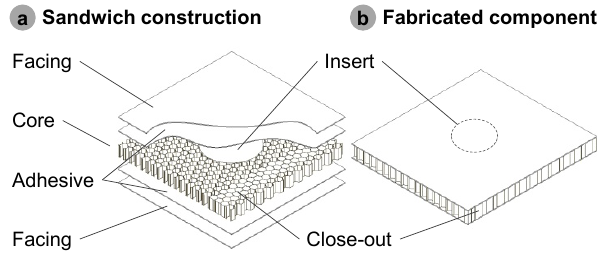
Figure 2. Schematic setup of sandwich structures with close-out and inserts (a) and fabricated component (b) according to Bitzer